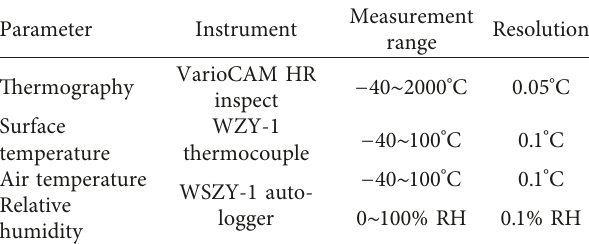
Measurement range